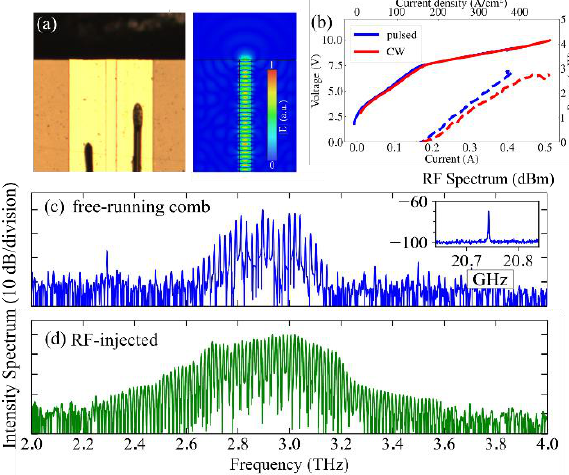
Fig. 2. (a) Microscope image of a ridge waveguide device. The cleaved facets act as mirrors, and standing waves form in the cavity, as shown on the right image with the E-field profile from a 3D numerical simulation of the propagating fundamental waveguide mode. (b) LIV curves of a 40 μm wide and 2.7 mm long device with a low threshold current density of around 140 A/cm 2 and peak powers around 3 mW at a heatsink temperature of 40 K. (c) Spectral measurement of a free- running device in a frequency comb state with a bandwidth over 600 GHz and a single RF beatnote (inset). (d) Injecting with a strong external RF signal (+35 dBm at source) close to the natural roundtrip freqeuncy broadens the THz emission to span over 1.4 THz.